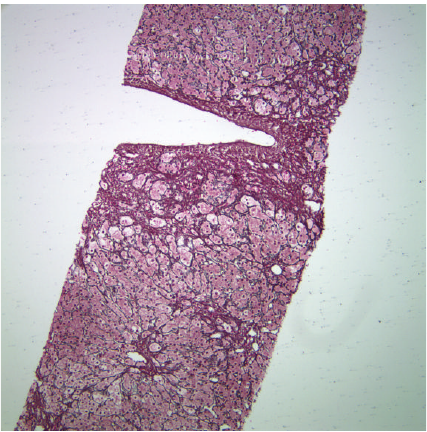
Figure3:Extensiveremodelingwithzone3to3bridging(reticulin).